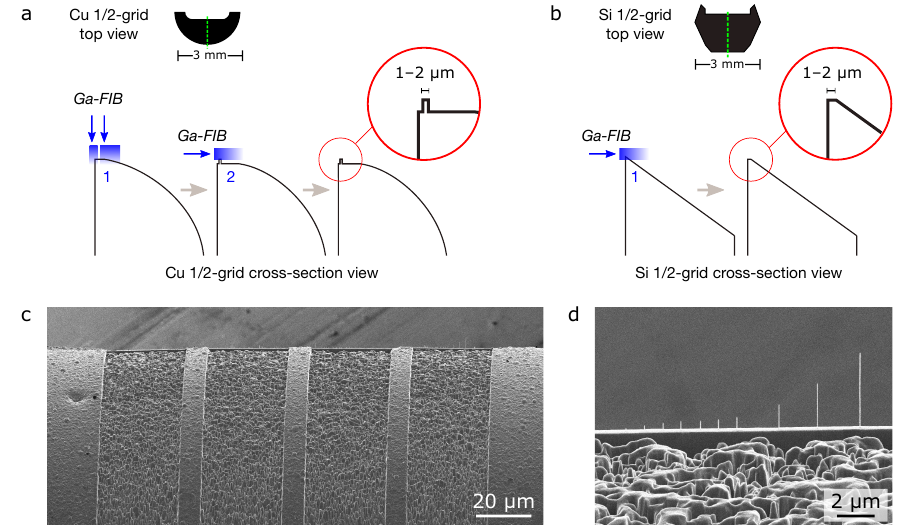
Figure 1. Preparation of TEM substrates for deposition experiments: ( a , b ) Schematics showing gallium FIB milling procedure to create flat and narrow platforms on the copper and silicon half- grids, respectively. The green dashed line in the top-down view of each grid marks the plane for the cross-section views (the latter are not drawn to scale). The first FIB milling step in ( a ) consisted of a coarse pre-mill at 1.5nA followed by clean-up mills of the sides of the platform using beam currents down to 100pA. In the second step, clean-up milling only of the top of the platform was performed at 100–300pA. In ( b ), milling was performed at the lower currents only, since less material had to be removed. ( c ) Helium ion microscopy (HIM) view of four platforms milled into a copper grid following the method shown in ( a ). Each platform has a length of 30µm and width of 1–2µm. ( d ) Higher-magnification HIM view of nanopillars deposited onto the 4th platform in ( c ). In this example, the tallest nanopillar (metallic) was deposited using a patterning dose of 640µC/µm 2